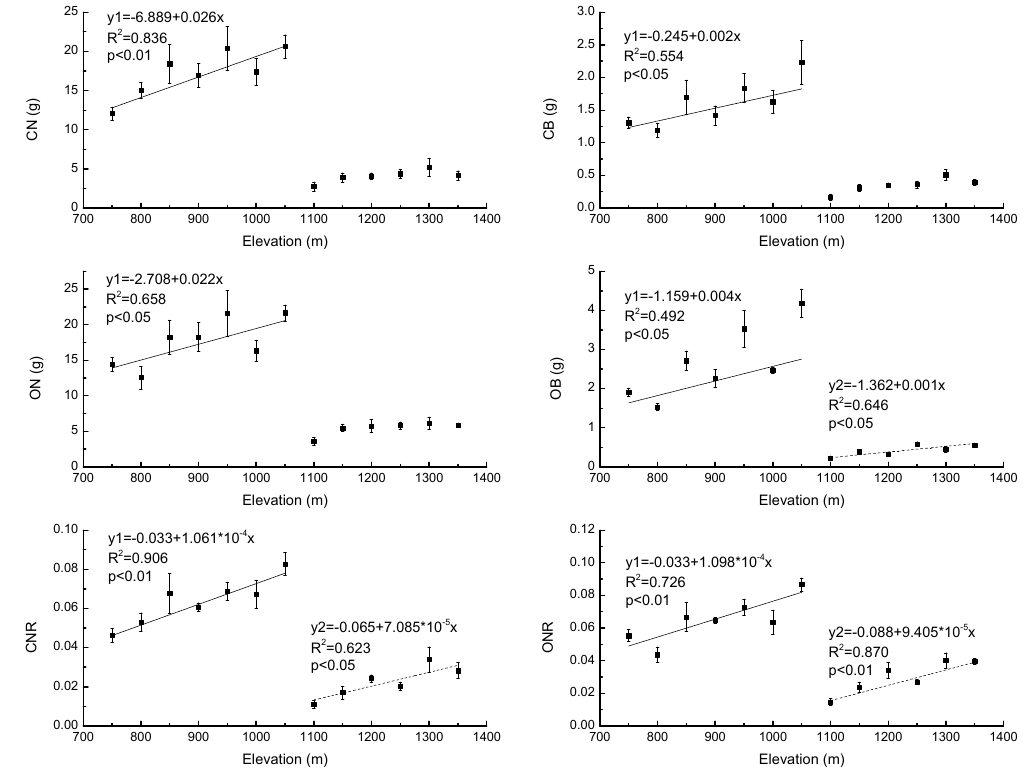
Figure 6. Regression equations of biomass of current-year needles (CN), biomass of current-year branches (CB), biomass of one-year-old needles (ON), biomass of one-year-old branches (OB), current-year needle biomass/total biomass ratio (CNR), and one-year-old needle biomass/total biomass ratio (ONR) of Pinus koraiensis at different elevations, Changbai Mountain. The sample size was 7 for Pinus koraiensis and mixed broadleaved forests (solid lines) and 6 for evergreen coniferous forests (dotted lines). For each elevation, the sample size was 5.